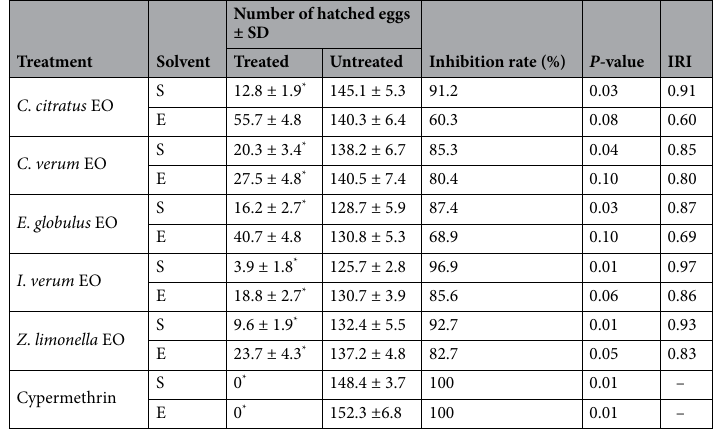
Table 2. Inhibition rate at 30 days against Periplaneta americana eggs of 10% solutions of five plant essential oils (EOs) and cypermethrin in soybean oil and in ethyl alcohol. IRI Inhibition Rate Index, S Soybean oil solution, E Ethyl alcohol solution, * Treatment and non-treatment are significantly different at P < 0.05.